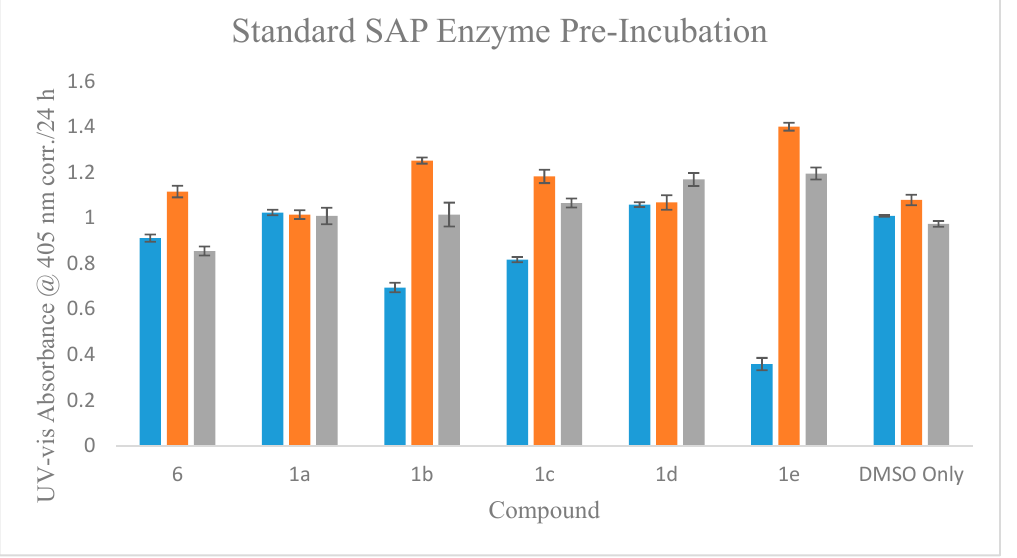
Figure 7. Absorbance values (A 405 nm) resulting from differing pre-incubation with polycyclic ether-benzopyrans. Values are the mean ± SD for n = 4 replicates. Blue: 15 min; orange: 18 h; gray: 46 h.